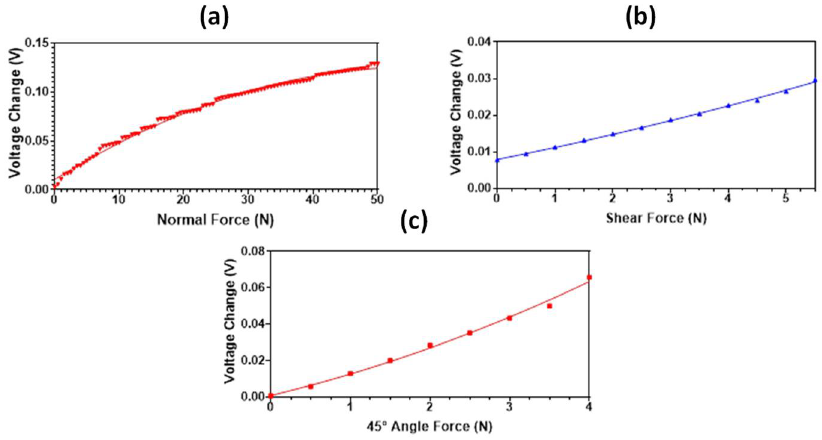
Figure 20. The output voltage response of the proposed magnetic tactile sensor with RTV-528 elastomer: ( a ) normal force, ( b ) shear force in +x direction, ( c ) 45° angular force.